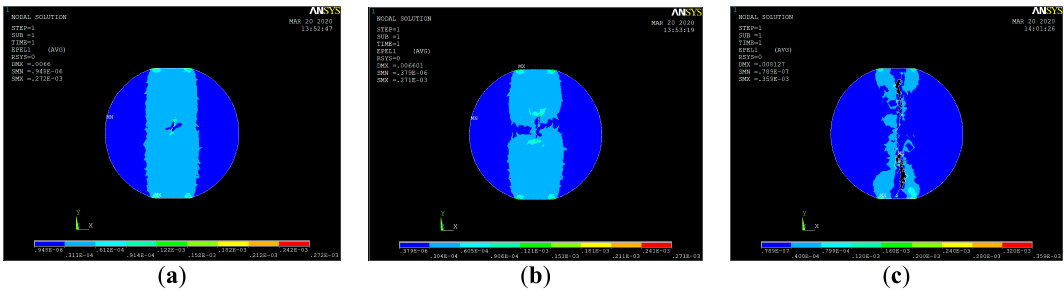
Figure 3. Strain cloud picture of the disk splitting process of Yellow River ice: ( a ) initial crack, ( b ) macro main crack development, ( c ) final failure